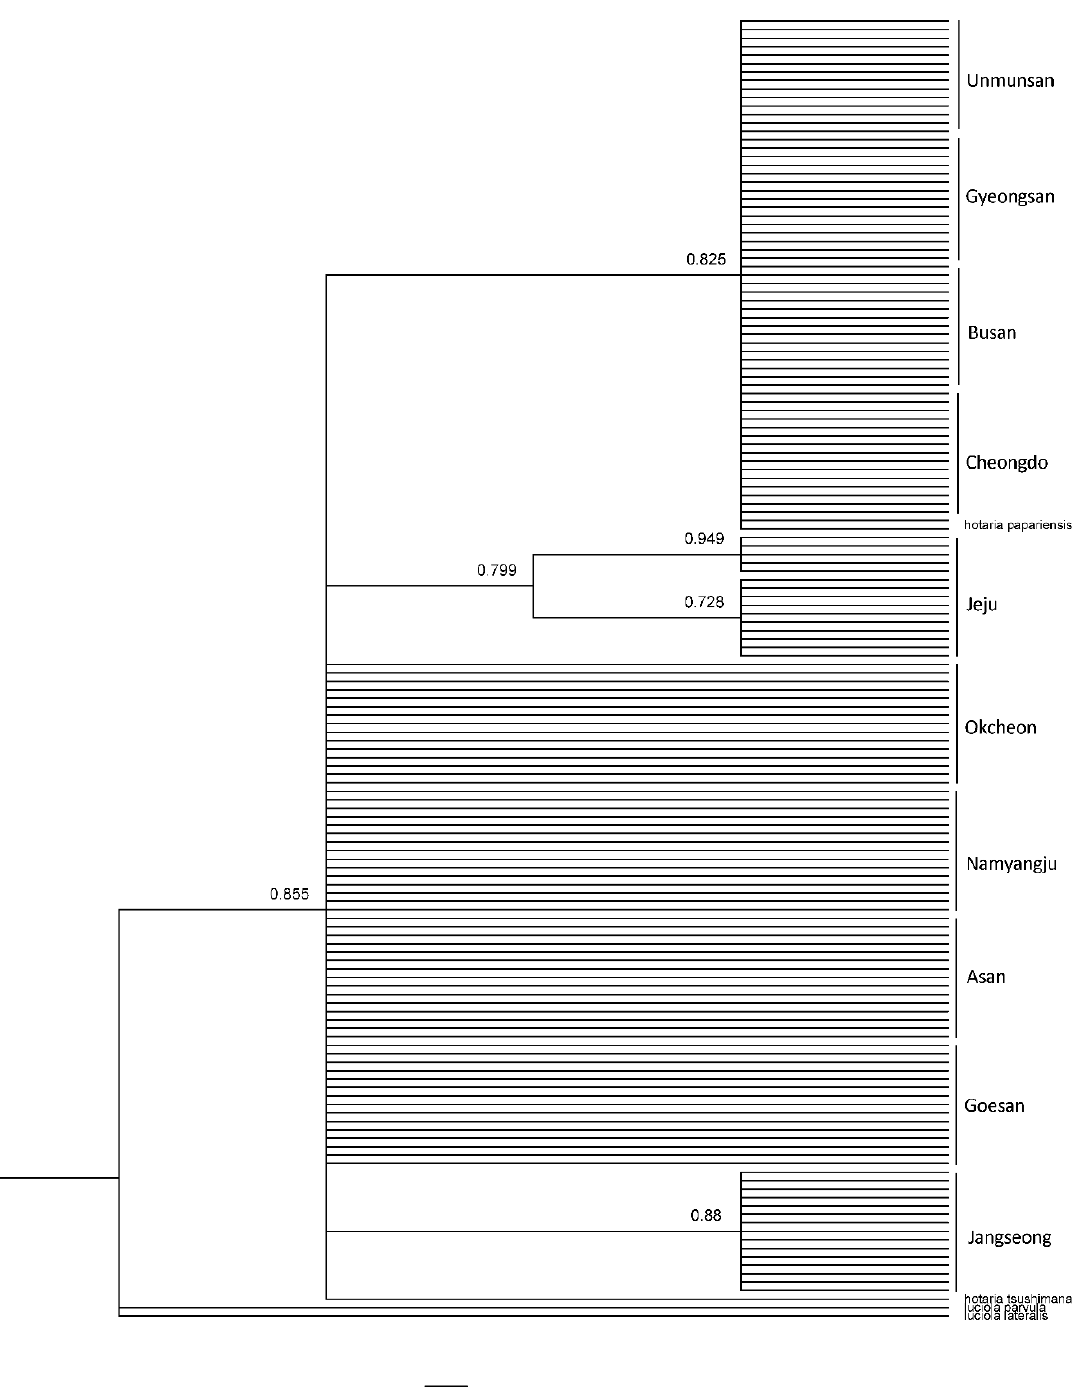
Figure 10. Phylogenetic analysis of 9 mitochondrial 16s rRNA gene of L. unmunsana . The tree was developed by the ML method using the MEGA software.